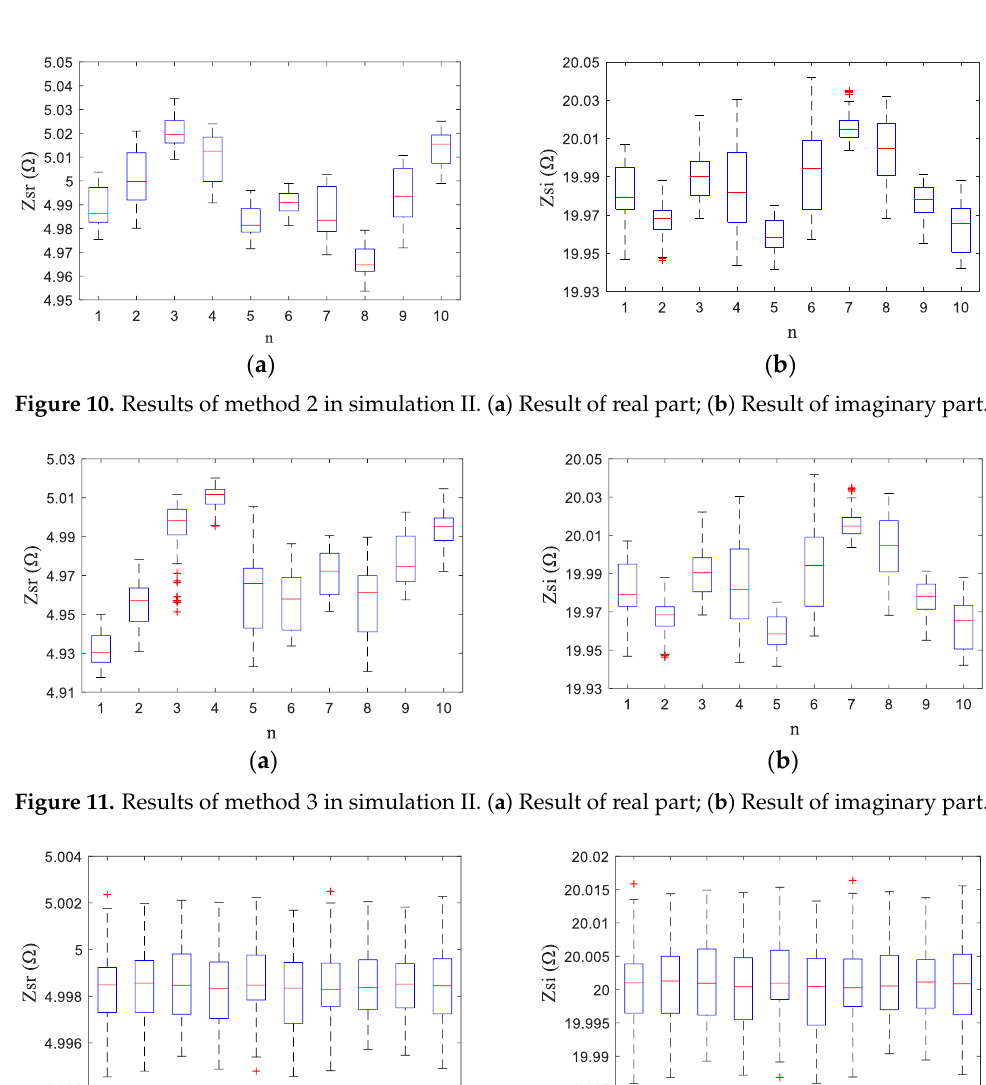
Figure 9. Results of method 1 in simulation II. ( a ) Result of real part; ( b ) Result of imaginary part.